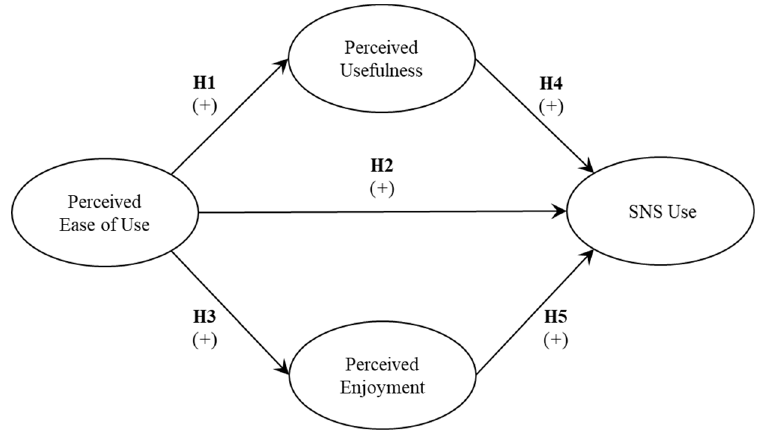
Figure 1. Research model.